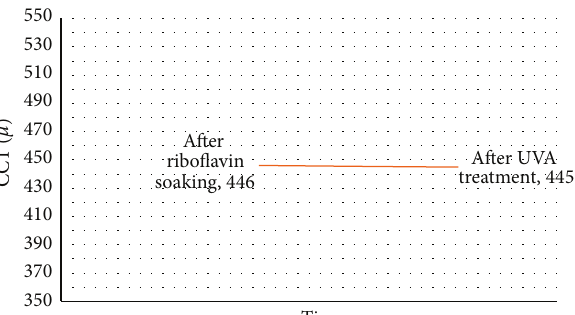
Figure 2: CCT changes (in microns) during UVA